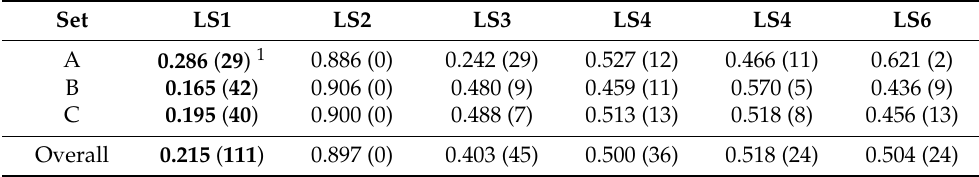
Table 4. Comparison of the list scheduling methods (the best values are in bold).